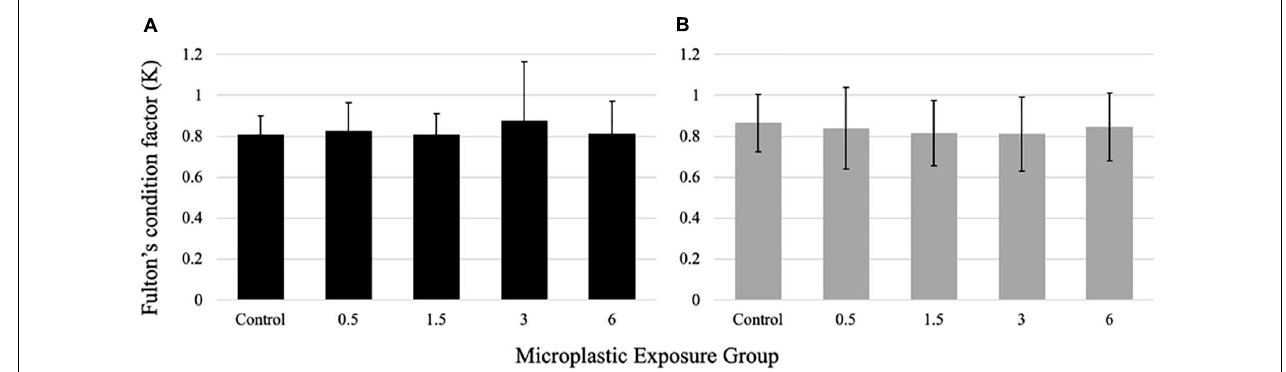
FIGURE 7 | Fulton’s Condition Factor (K) for larval (A) and juvenile (B) medaka after 21 days of exposure to 0, 0.5,1.5, 3, and 6 fibers/fish per day. Data are displayed as mean ± standard deviation (nested ANOVA, * p < 0.05, n = 5 pools of 50